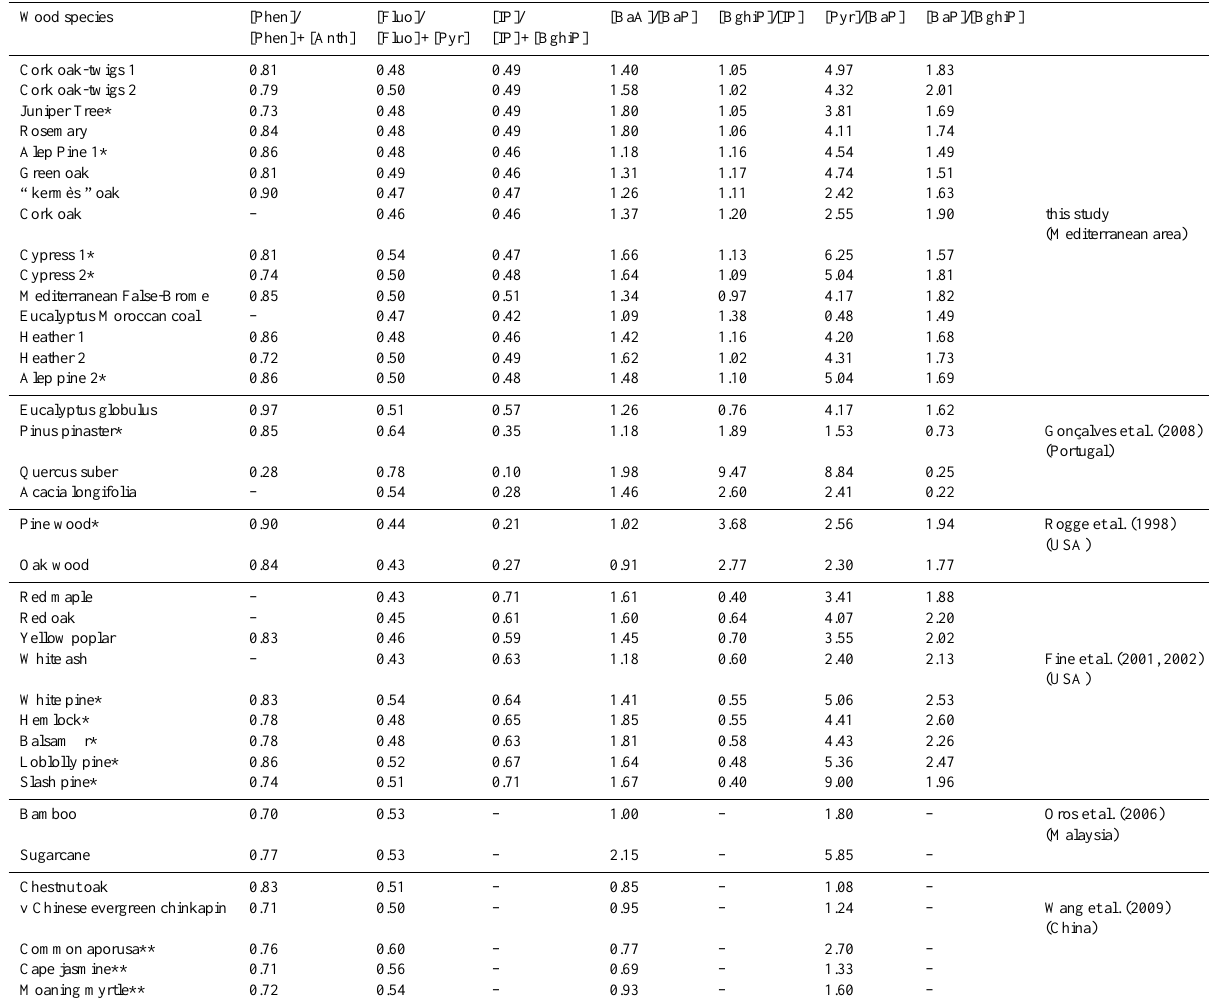
Table 6. PAH diagnostic ratios of wood combustion. Wood